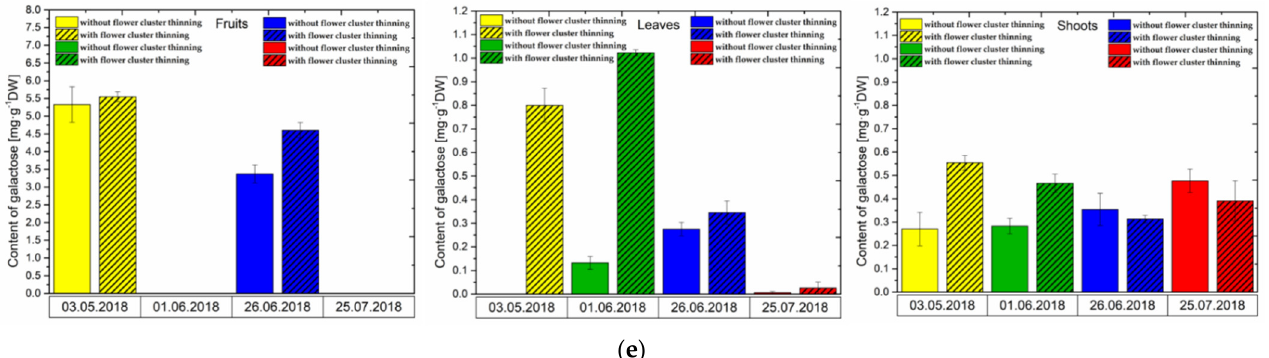
Figure 7. Total Sugar Content ( a ), Glucose ( b ), Fructose ( c ), Sucrose ( d ), Galactose ( e ) in Organs of Pistachio Trees With or Without Flower Cluster Thinning Application.